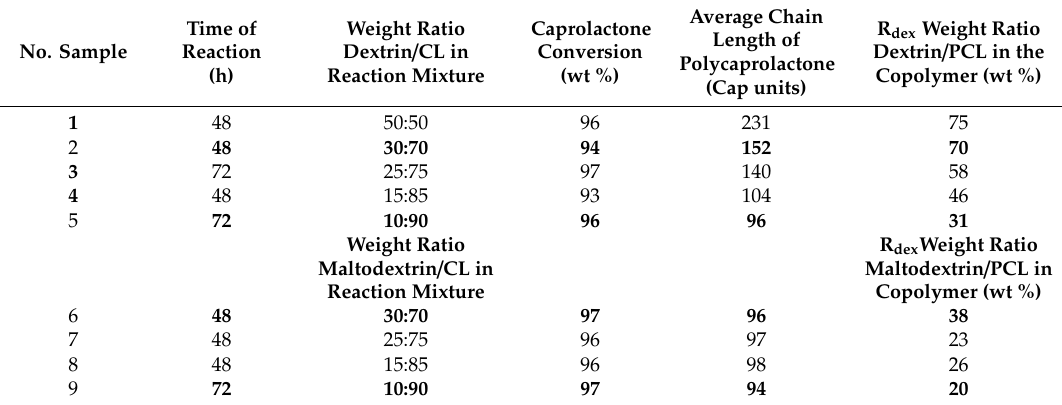
Table 1. Conditions of the grafting reactions and characteristic of the final